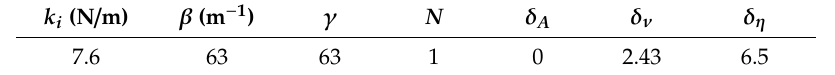
Table 1. Parameters of the BWBN model adopted for simulating the record data.